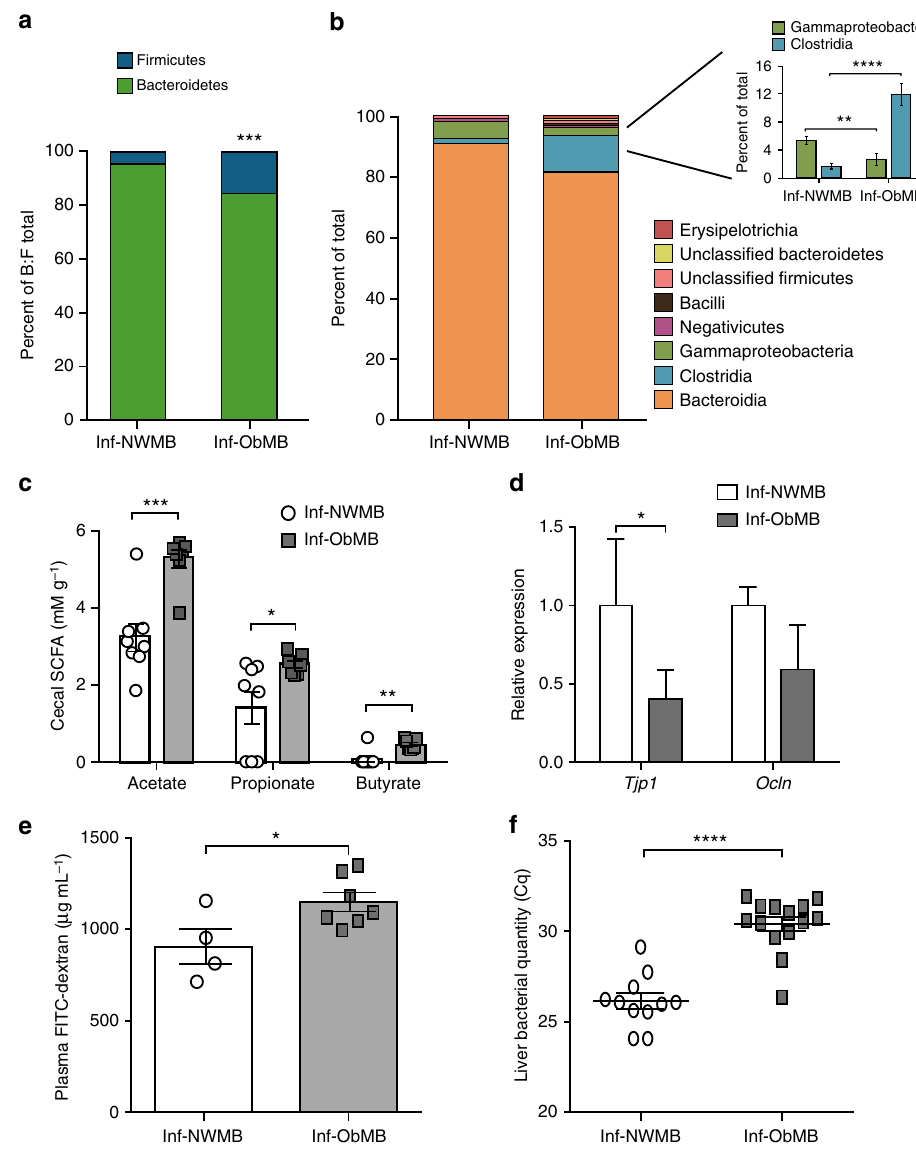
Fig. 2 Inf-ObMB alters gut microbiome and increases intestinal permeability. Bacteroidetes to Firmicutes (B:F) ratio in the cecal microbiota depicted as percent of total of these two phyla ( a ) and class level relative abundance ( b ), with the percent of total highlighted for Gammaproteobacteria and Clostridia, after 21 days of colonization; n = 6 for both Inf-NWMB and Inf-ObMW groups. c Acetate, propionate, and butyrate SCFA concentrations measured in the cecum; n = 8 for Inf-NWMB, n = 7 for Inf-ObMB. d Relative mRNA expression of Tjp1 and Ocln measured in the colon, normalized to Gapdh and 18S rRNA; n = 8 for Inf-NWMB, n = 7 for Inf-ObMB. e FITC-dextran translocation into plasma; n = 4 for Inf-NWMB, n = 7 for Inf-ObMB. f Quantity of 16S DNA in liver; Cq, quanti fi cation cycle; n = 11 for Inf-NWMB and n = 14 for Inf-ObMB. c – f Data are presented as mean ± SEM. * P < 0.05, ** P < 0.01, *** P < 0.005, and **** P < 0.0001 by Student ’ s t